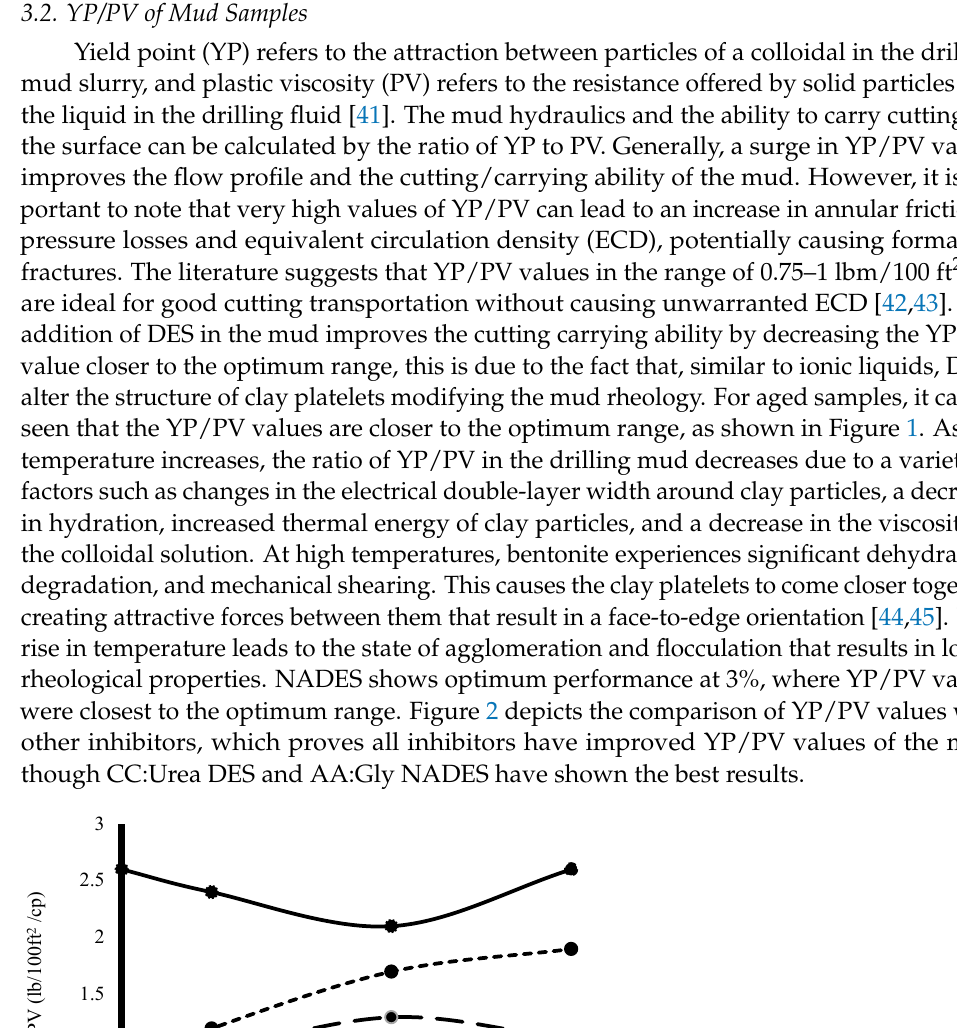
Figure 2. Comparison of YP/PV of NADES-based mud with other inhibitors. 3.3. Filtration Properties of Mud Samples Ascorbic acid-based NADES performed exceptionally well under high-temperature, high-pressure conditions. Compared to the base sample, the addition of NADES not only reduced the thickness of the mud cake but also decreased the filtrate volume, as shown in Figures 3–5. Problems such as drill pipe sticking can occur when there is a thick mud cake, which is why thinner is added to the drilling mud to decrease its thickness. NADES in the mud acts as a thinner, reducing the thickness of the mud cake and filtrate volume. This is likely due to the NADES’ ability to interact with clay platelets and change their wettability, thus reducing the thickness of the mud cake. Using 3% NADES without aging resulted in a minimum mud cake thickness of 1.2 mm and 18 mL of filtrate loss, as shown in Figures 3 and 5. The addition of 3% NADES resulted in a 39.69% reduction in mud cake thickness and 28% reduction in filtrate volume compared to the base sample. When the aging temperature is increased, clay particles flocculate and aggregate, leading to a thicker mud cake and increased filtrate loss, as also shown in Figures 3 and 5. Figures 4 and 6 present a comparison of filtration properties of 3% AA:Gly NADES-based mud with other inhibitors. Among all inhibitors, NADES gave the best filtration properties, followed by CC:Urea DES, then, ionic liquids, and lastly, KCl. More discussion of the results is provided in Section 4. Moreover, error bars are drawn in Figures 3 and 5, based upon 5% error margin.